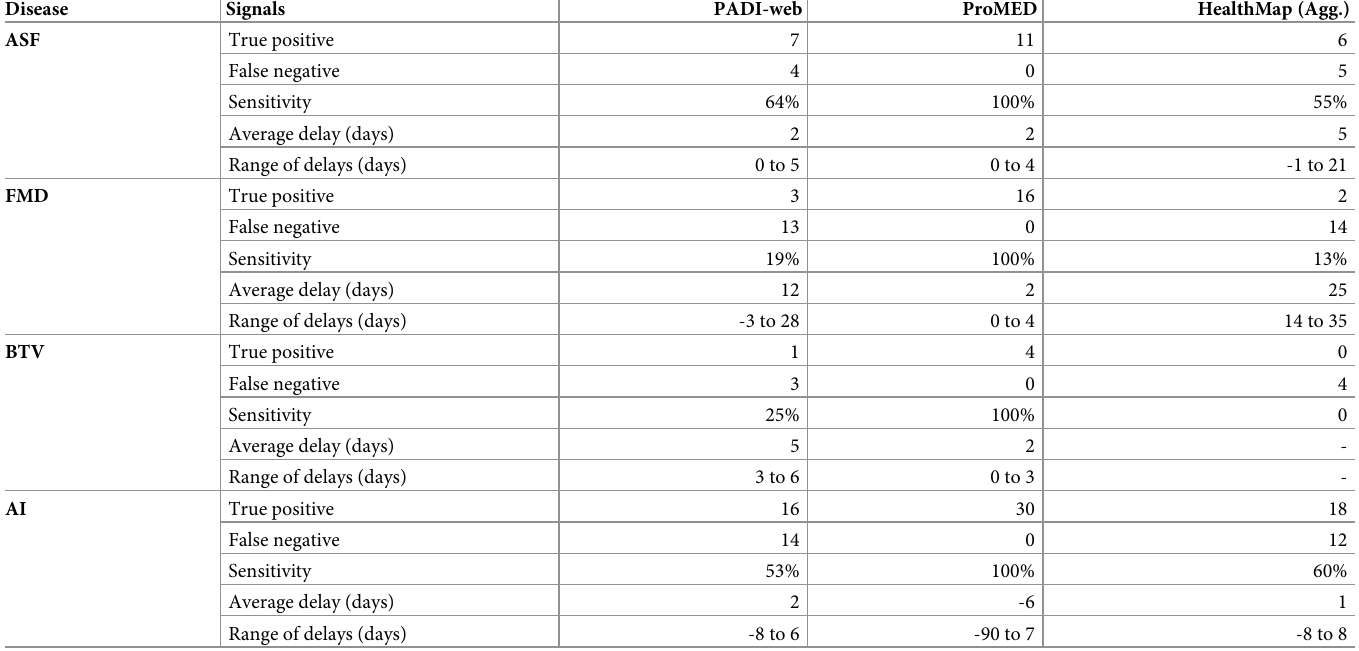
Table 4. Sensitivity and timeliness of PADI-web, ProMED and HealthMap (Agg.) in detecting primary outbreaks of African swine fever (ASF), foot-and-mouth dis- ease (FMD), bluetongue (BTV) and avian influenza (AI) from January to June 2016.